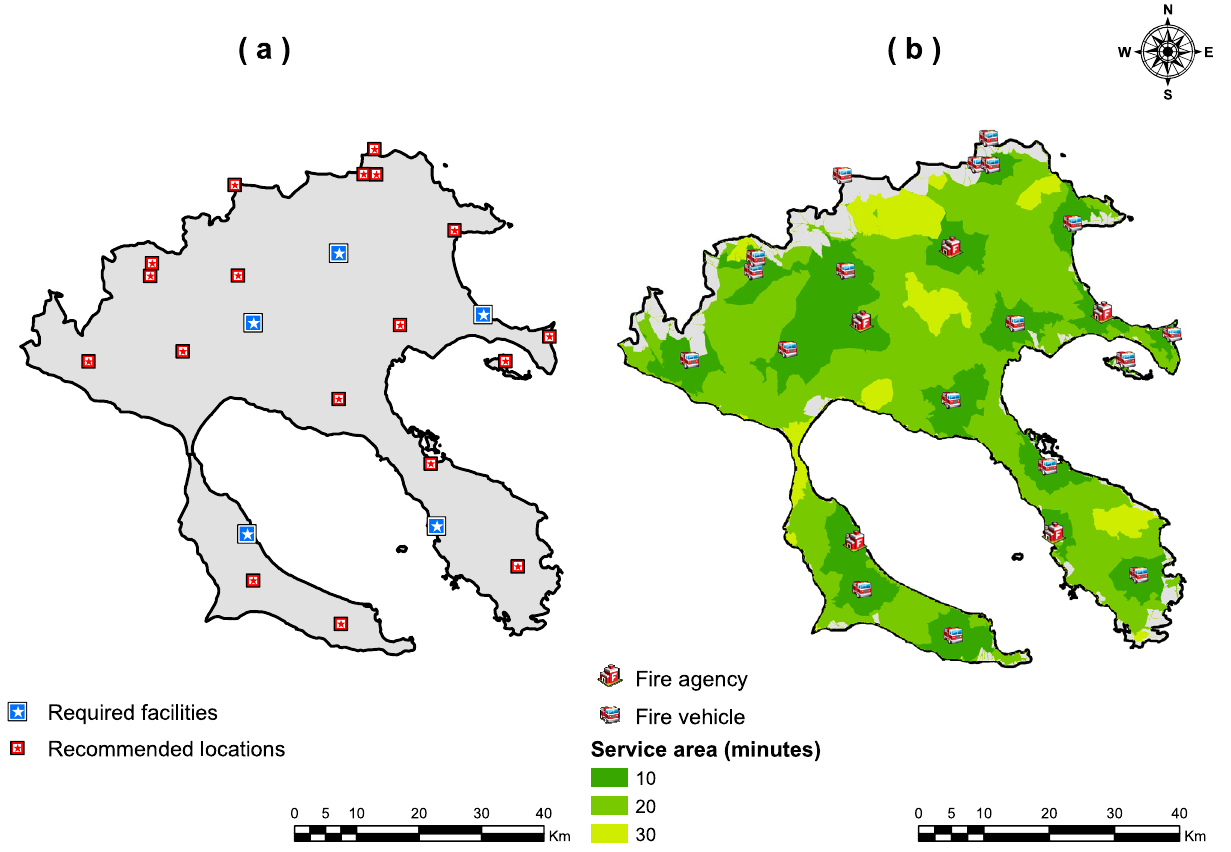
Fig. 6 Estimation of the minimum number of locations for initial attack (without topography effect) maximizing the coverage of the most sus- ceptible regions. a Spatial determination of recommended locations; b Service area of the selected locations in the Chalkidiki study